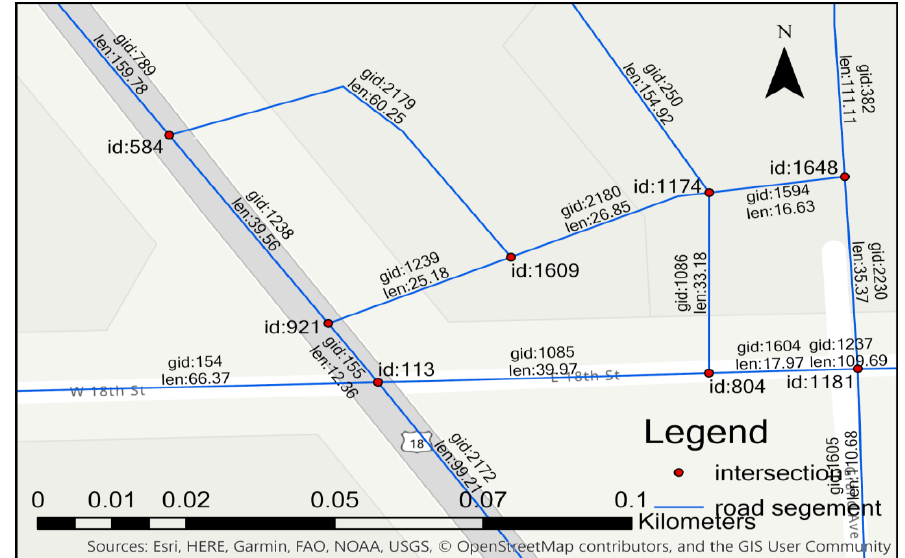
Figure 9. Typical T-intersections and cross-intersections.